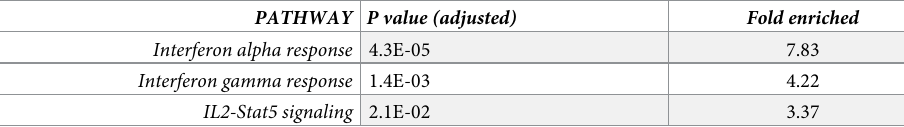
Table 2. Enriched pathways in the inflammatory type of